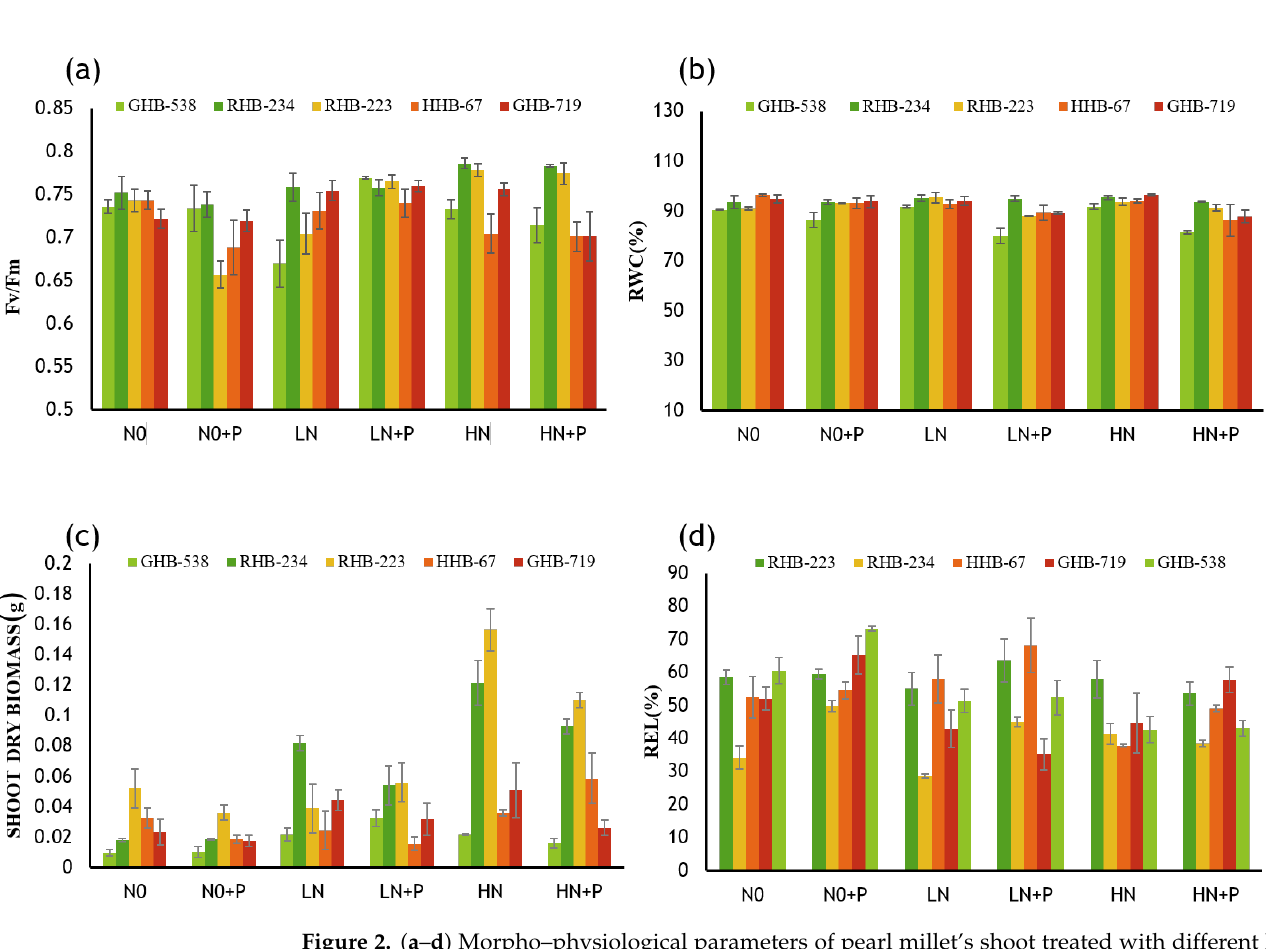
Figure 2. ( a – d ) Morpho – physiological parameters of pearl millet`s shoot treated with different N treatments (N0,LN,HN) and drought stress (P (PEG-6000-10%)). Bars are means ± SE ( n =